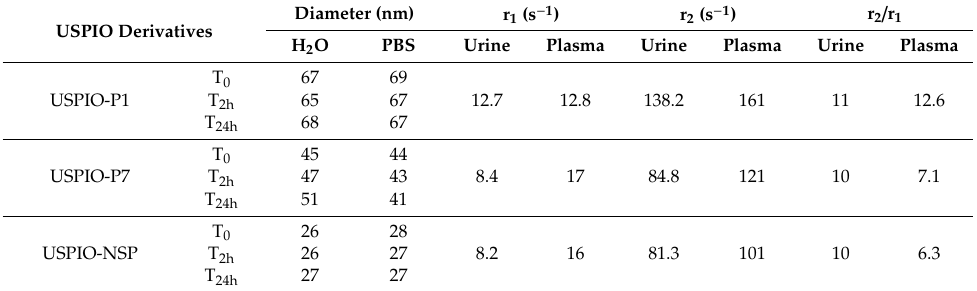
Table 1. Hydrodynamic diameter values (nm) of vectorized nanoparticles as a function of solvent over time. The relaxivity values r 1 and r 2 were measured at 60 MHz and 37 ◦